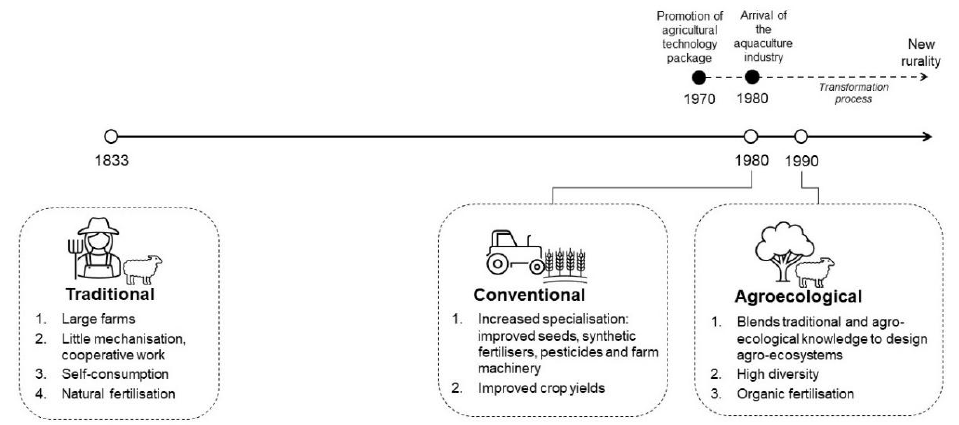
Figure 2. Diagram of the evolution of agriculture on Chiloé. Based on: [24,26,35,52]